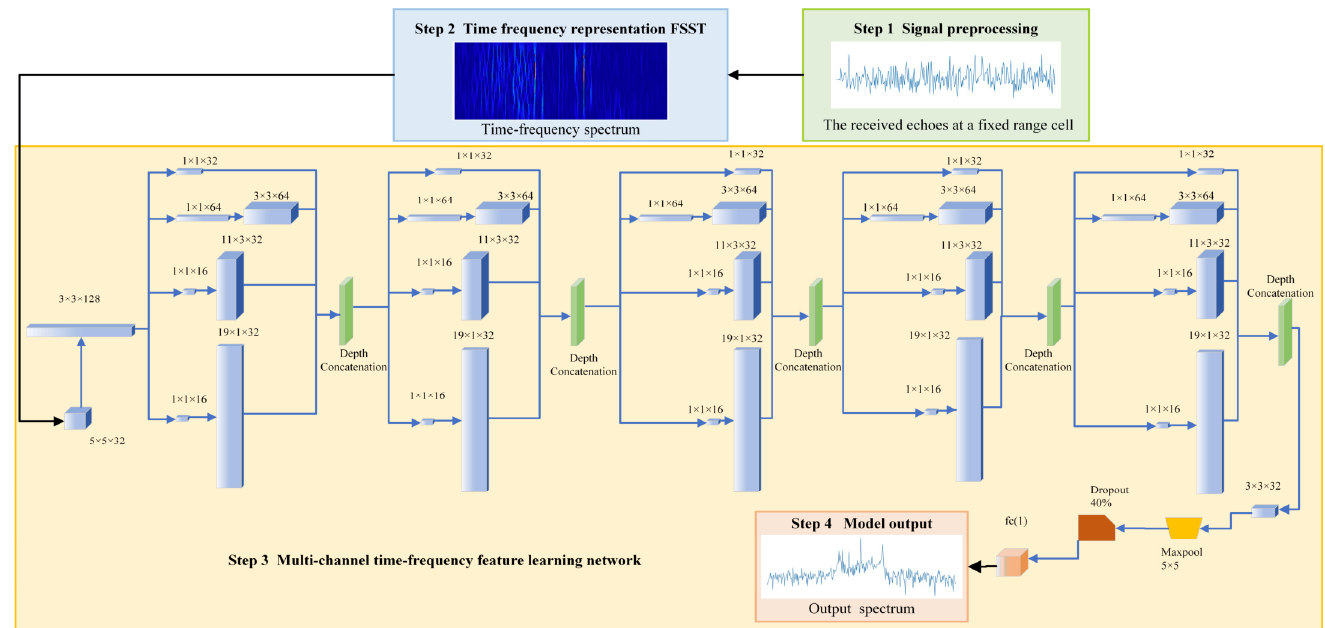
Figure 2. The structure diagram of the proposed DL-TFF.